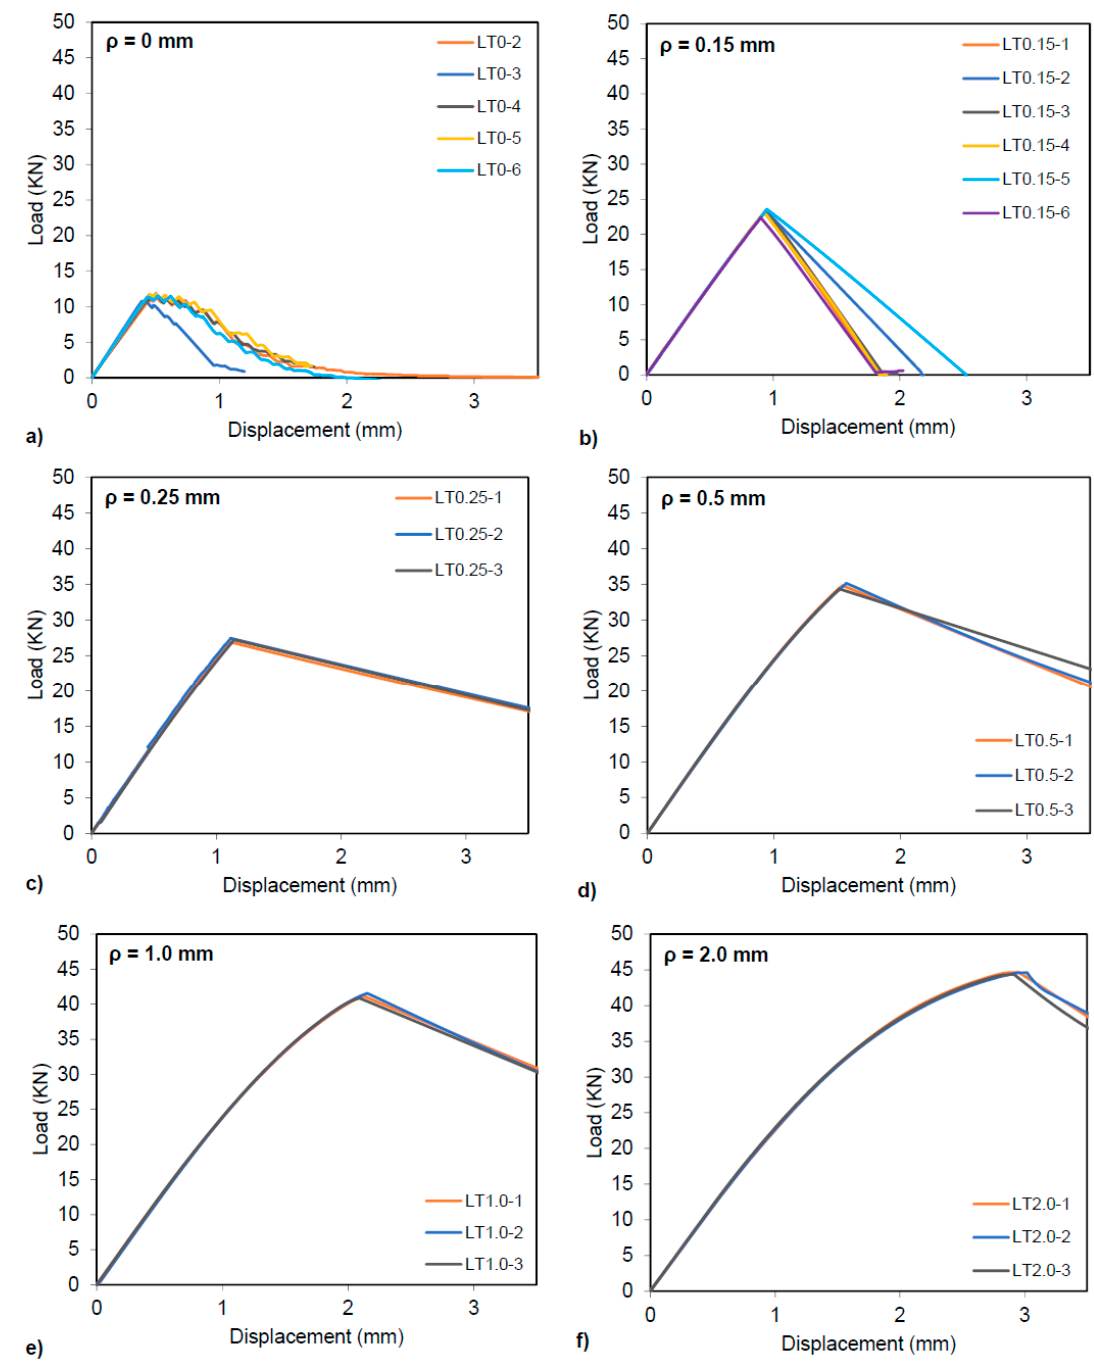
Figure 7. Load-displacement curves for LT specimens with different notch radius. ( a ) 0 mm, ( b ) 0.15 mm, ( c ) 0.25 mm, ( d ) 0.5 mm, ( e ) 1 mm, ( f ) 2 mm [3].